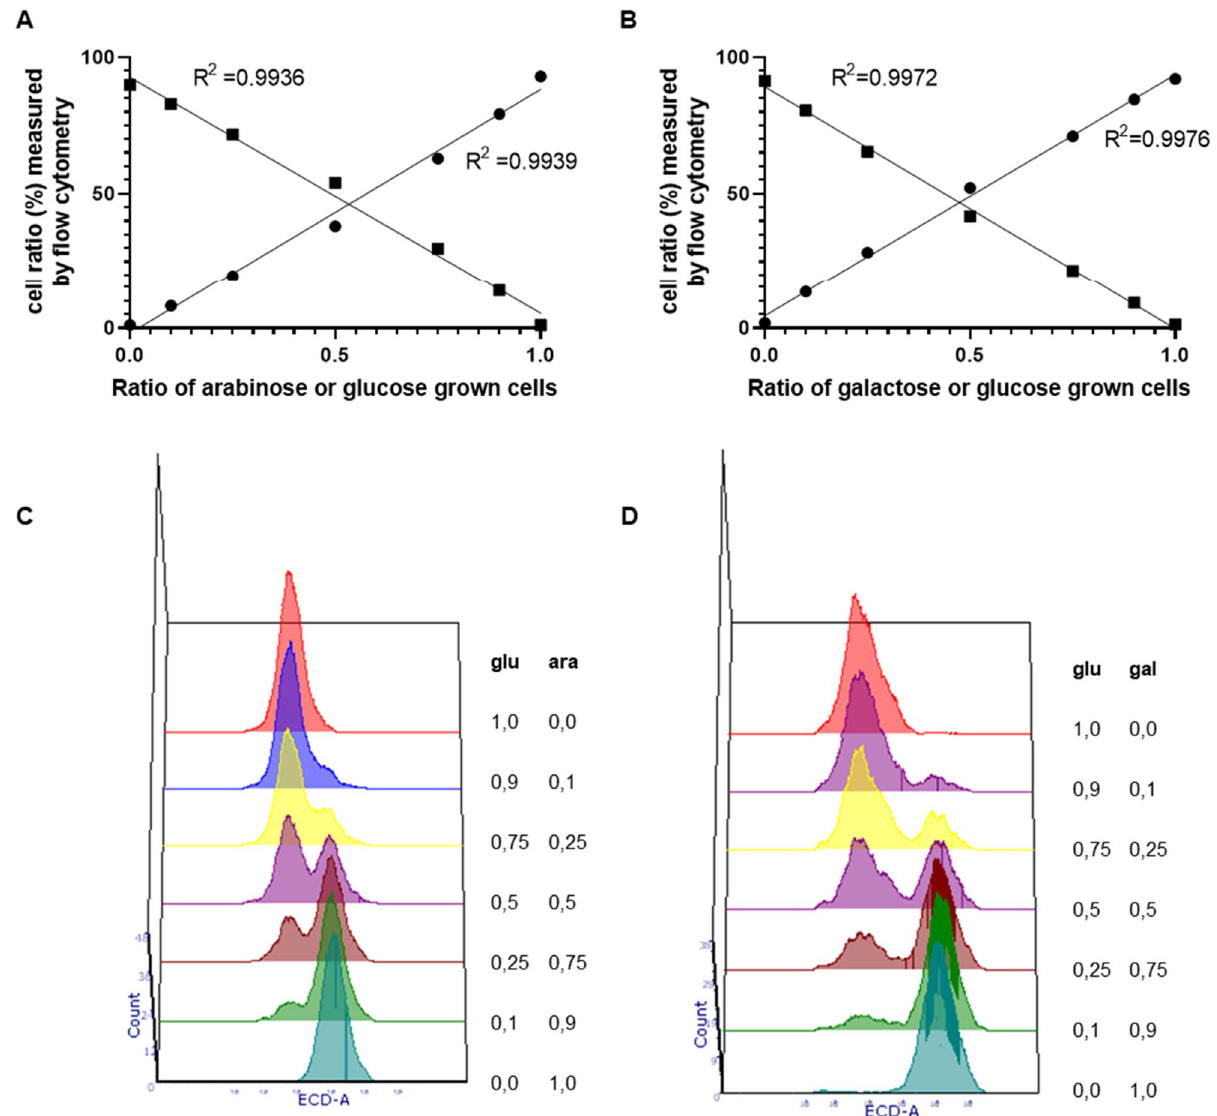
Figure 3. Flow cytometry scatter plots of stationary grown B. longum NCC 2705 cells harboring the pSDU30 (P BL1359 -mCherry) (panel A and C ) and the pSDU32 (P BL1694 –mCherry) (panel B and D ) constructs. Populations were mixed at different ratios (A & C [glucose:arabinose cells], B and D [glucose:galactose cells]) of 1.00:0.00, 0.90:0.10, 0.75:0.25, 0.50:0.50, 0.25:0.75, 0.10:0.90 and 0.00:1.00. Quantification of high (circles) and low (squares) fluorescent populations in the different mixes was performed by flow cytometry. Lines represent linear regression for each population (Panels A and B